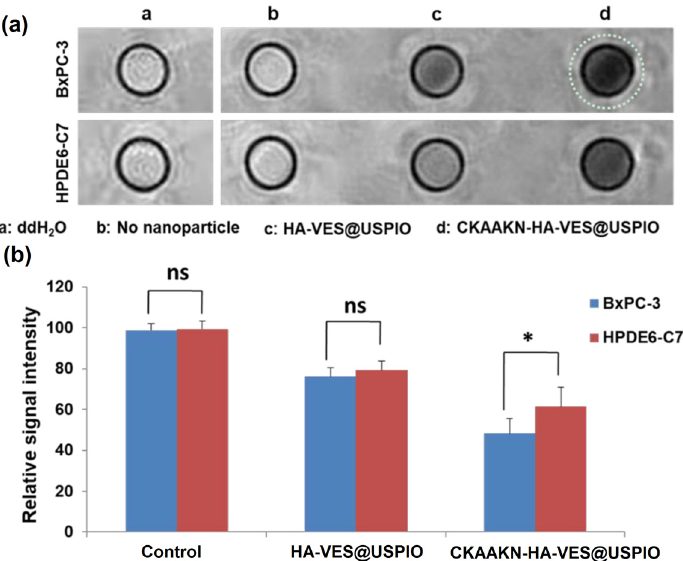
Figure 16. ( a ) In vitro magnetic resonance imaging (MRI) and ( b ) relative MRI signal intensities calculated with ImageJ software of BxPC-3 and HPDE6-C7 cells incubated with magnetic nanoparticles modified with and without CKAAKN (*: ImageJ p value < 0.05). Reproduced from reference [44].